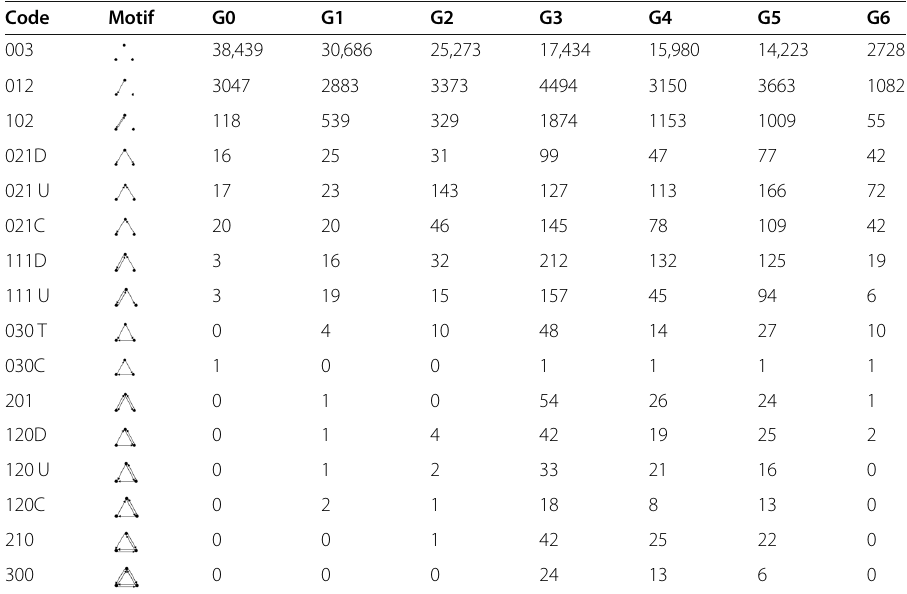
Table 3 Number of appearances of each triadic motif in identified network communities Code